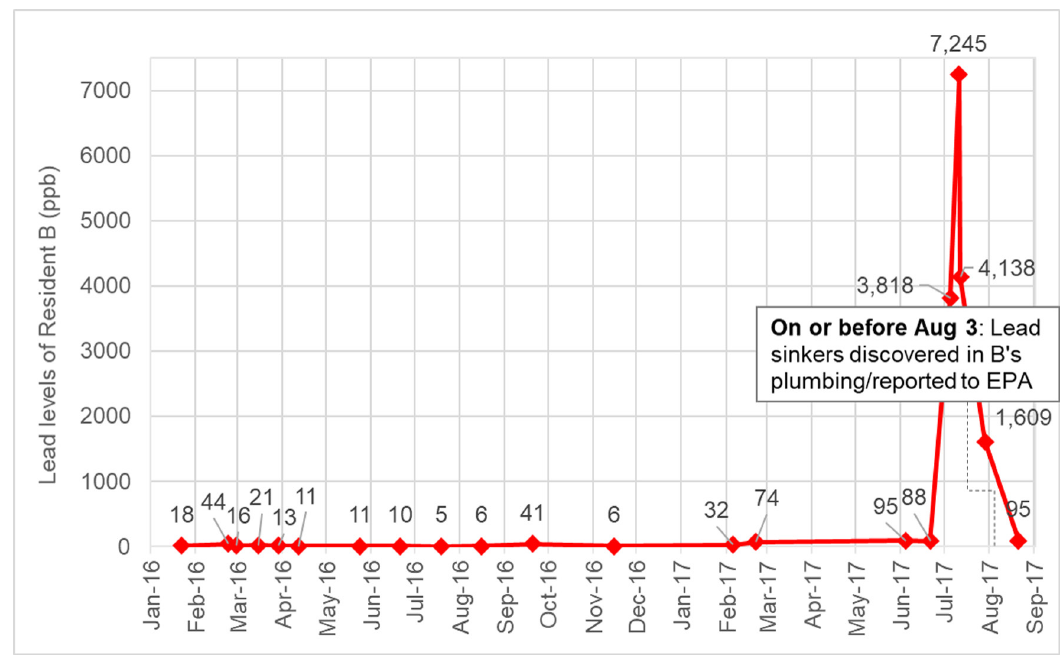
Figure 6: Resident B’s lead levels (2016–17) during and after the Flint Water Crisis (Source: MDEQ, publicly available social media